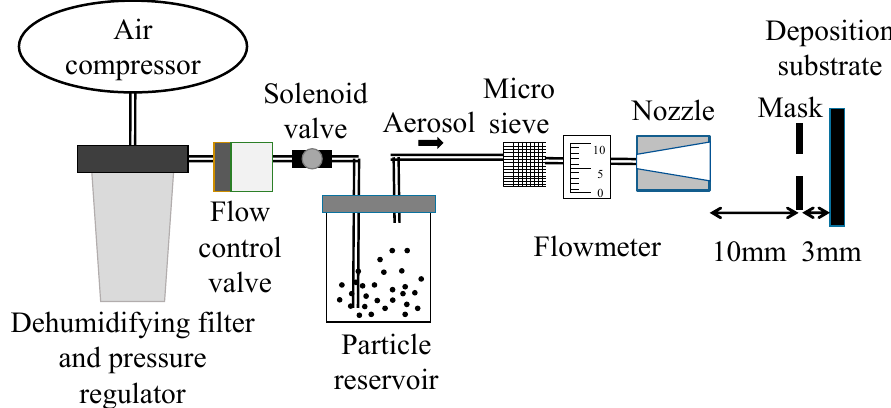
Figure 1. Aerosol generation and deposition system.